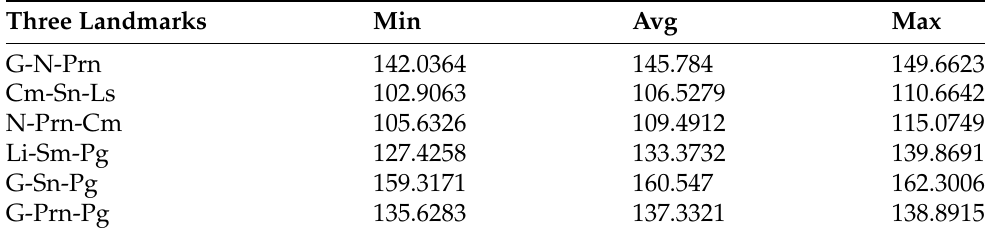
Table 4. Variation of angular measurement